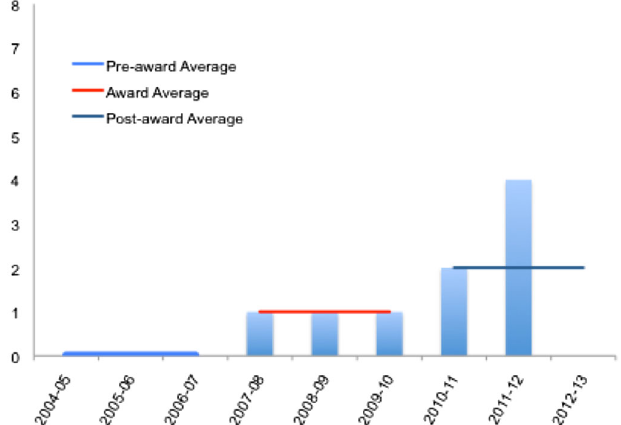
FIG. 7. Lessons learned from Florida International